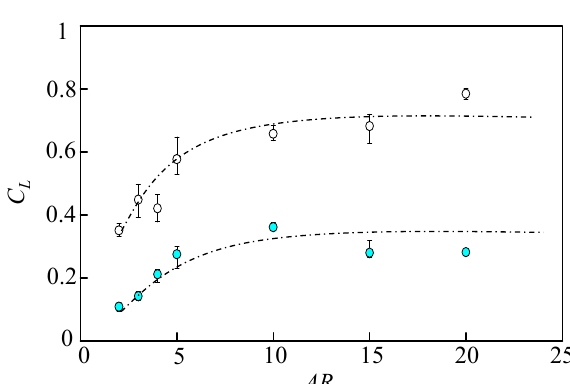
Fig. 8 Lift coefficient C L versus aspect ratio AR at depth-to-width ratio λ = 0.3, C = 3.86 × 10 2 .